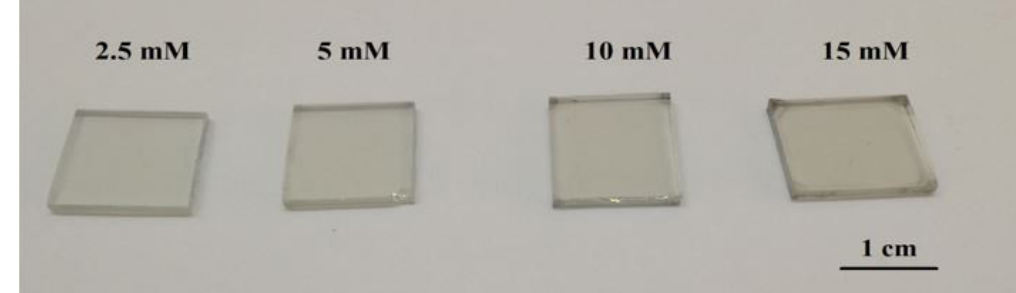
Figure 8. Pictures of Pt/FTO thin films with different precursor